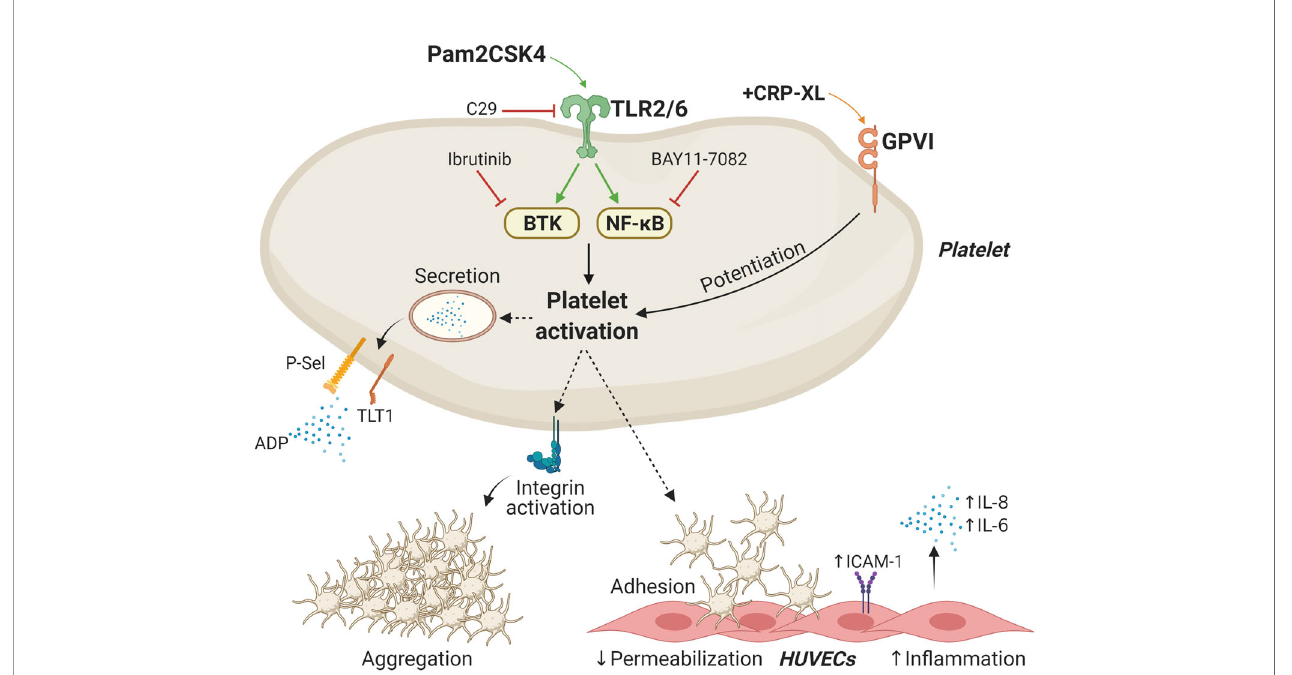
FIGURE 7 | Schematic representation of Pam2CSK4 effects in platelets and platelet-HUVECs interactions. Activation of the TLR2/TLR6 complex by Pam2CSK4 initiates a series of signaling events involving BTK and NF- k B to promote platelet activation. Functional responses triggered by Pam2CSK4 include d - and a -granule secretion as well as integrin activation and subsequent aggregation. Activation of platelet TLR2/TLR6 also promotes the adhesion of platelets to endothelial cells and increase endothelial cell in fl ammation. BTK, Bruton`s tyrosine kinase; HUVECs, Human umbilical vein endothelial cells; ICAM-1, intercellular adhesion molecule 1; TLT1, Trem-like transcript 1; NF- k B, nuclear factor- k B; GPVI, glycoprotein VI. Image created with